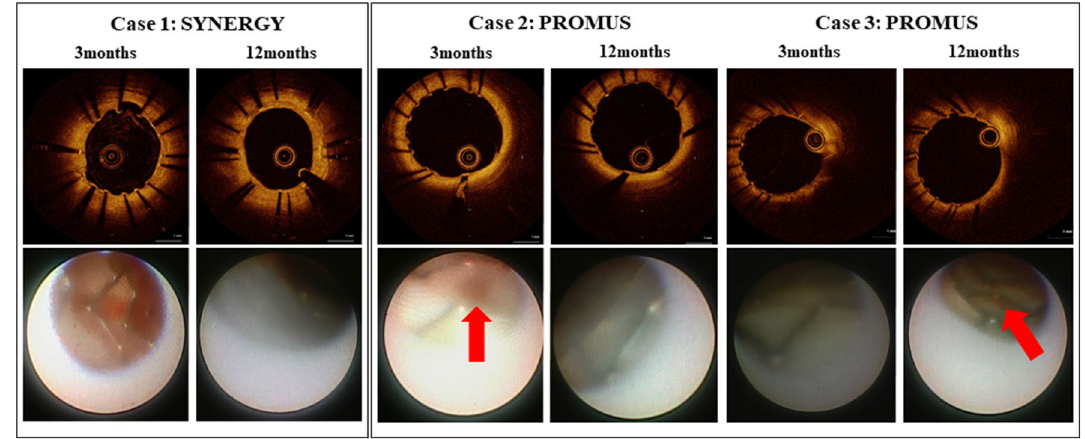
Figure 5. Representative OCT and coronary angioscopic findings. Red arrows: thrombus.